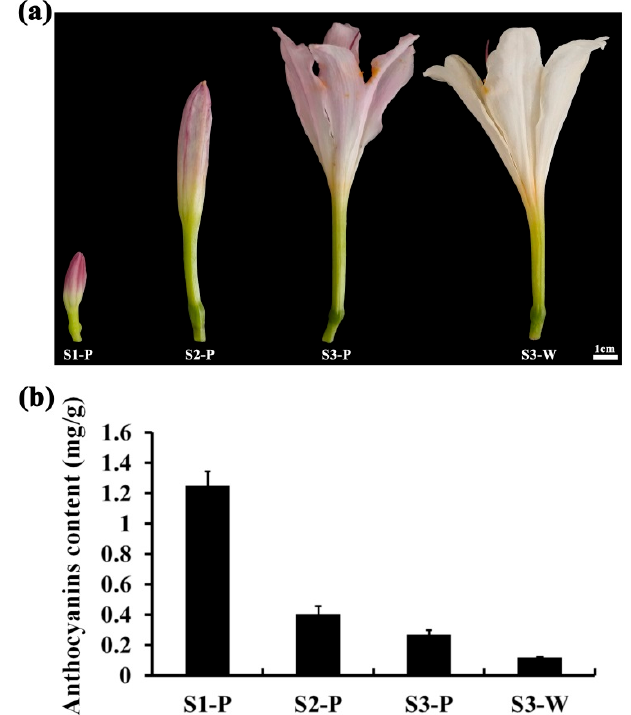
Figure 1. Lycoris longituba tepals and anthocyanin content at different samples. ( a ) Tepals of L. longituba ‘Pink’ and ‘White’ used for de novo transcriptome assembly (S1-P: small bud stage of L. longituba ‘Pink’; S2-P: medium bud stage of L. longituba ‘Pink’; S3-P: opening stage of L. longituba ‘Pink’; and S3-W: opening stage of L. longituba ‘White’); ( b ) content of anthocyanin in different tepal stages.